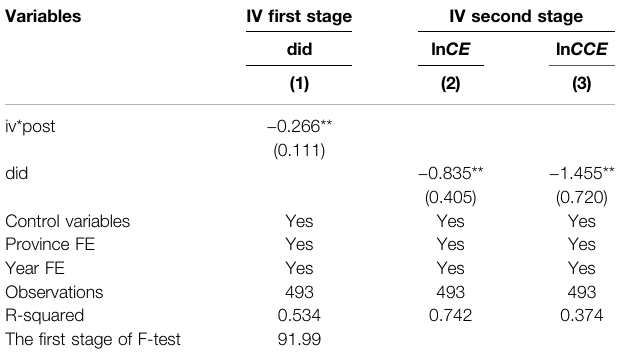
TABLE 3 | Regression results of instrumental variable approach.